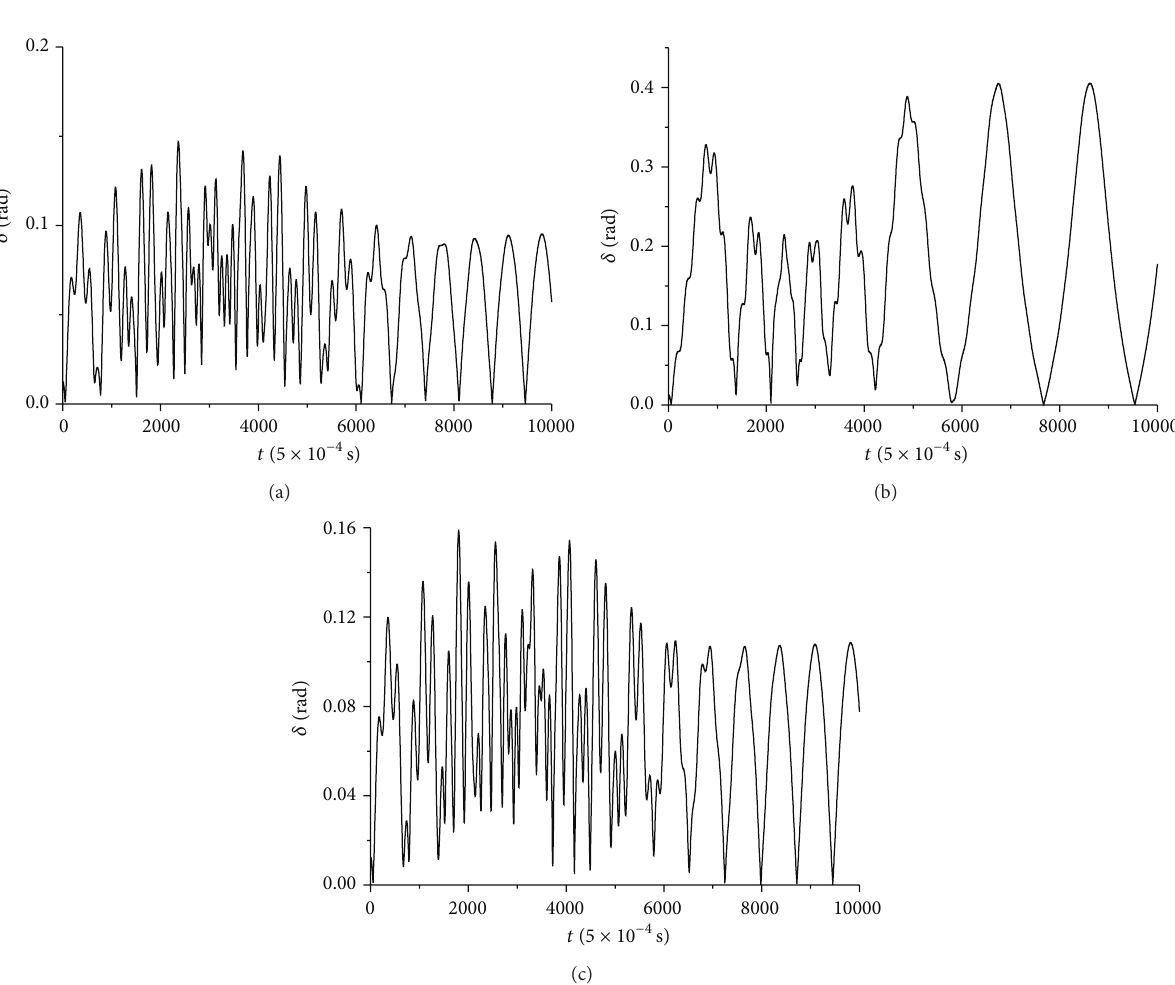
Figure 5: Ellipsoid’s angle 𝛿 between the vertical axes of the ellipsoid and its surface time-series in the case of (a) wax (b) gypsum, and (c) lead